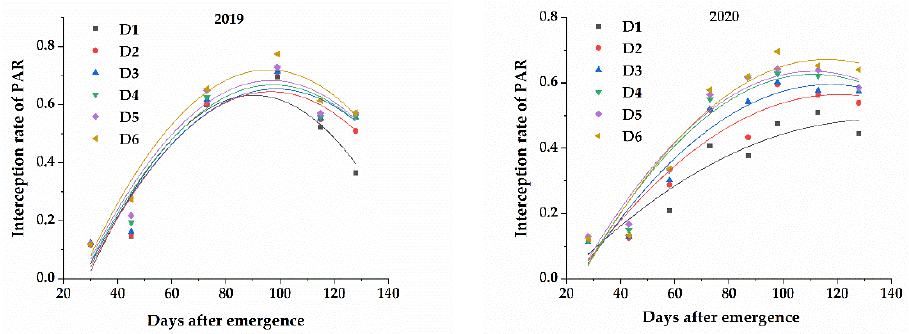
Figure 3. Interception rate of PAR at different planting densities in 2019 and 2020.